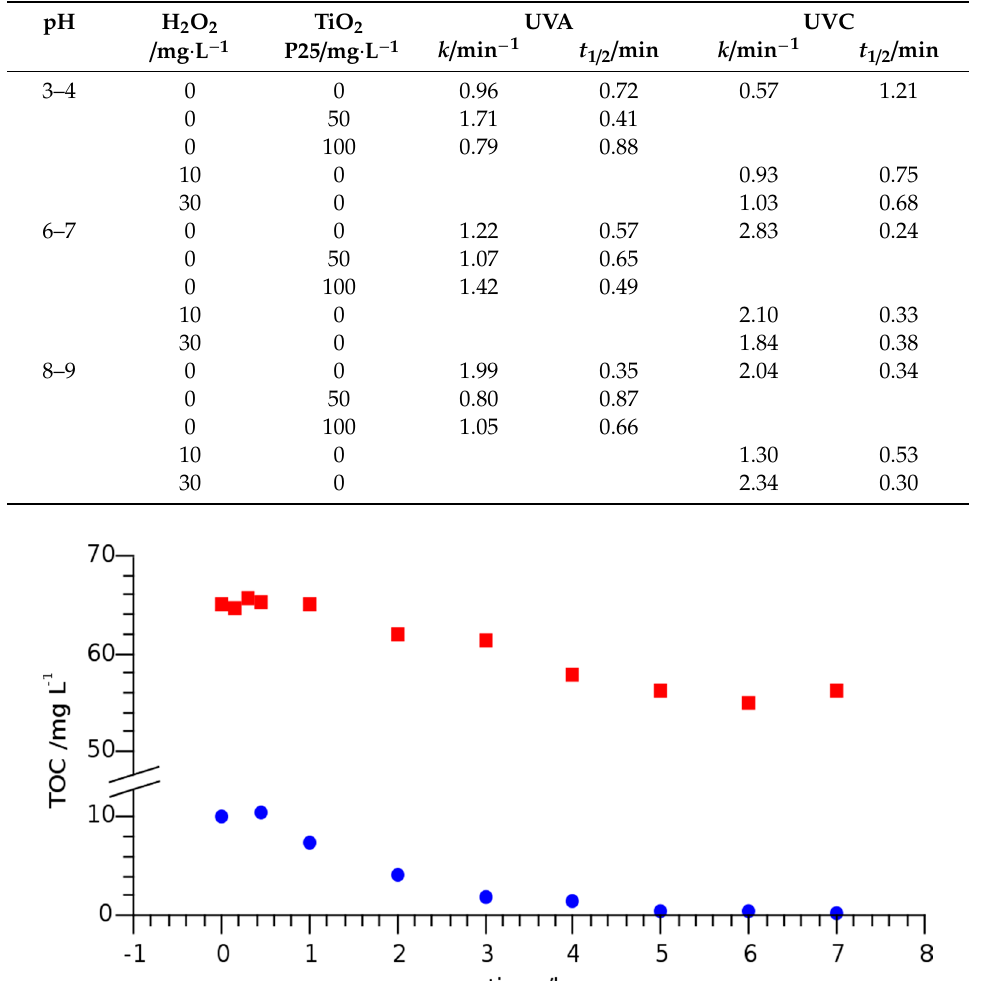
Table 3. Determined rate constants and the resulting half-lives with UVA and UVC irradiation and H 2 O 2 or TiO 2 addition.